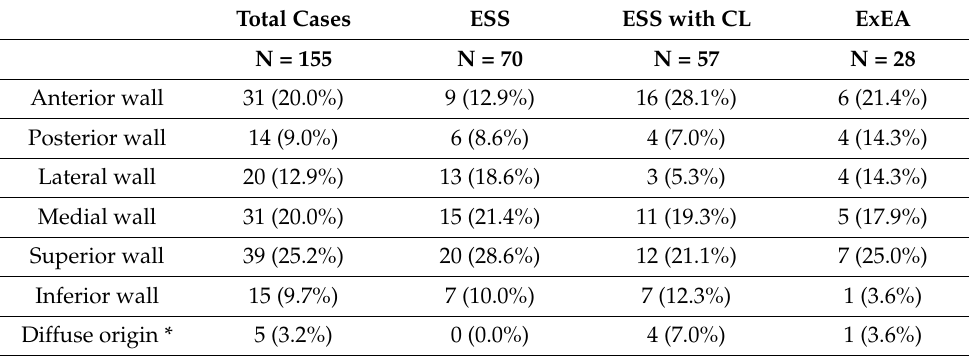
Figure 5. Kaplan–Meier plot for the subgroup analysis of primary cases. There were seven recur- rences among the primary cases: ESS, 10.2% (6/59); ESS with CL, 3.0% (1/33); and ExEA, 0% (0/25). There were significant differences in recurrence rates between the three groups ( p = 0.010, log-rank test). The ExEA group had a lower recurrence rate than the ESS group at 74.2 months after surgery ( p = 0.035, fixed time-point survival test). ExEA—expanded endoscopic approach; ESS—endoscopic resection via middle meatal antrostomy and/or inferior meatal antrostomy; ESS with CL—ESS with the Caldwell–Luc approach or canine fossa trephination. Table 2. Origin site in the maxillary sinus.